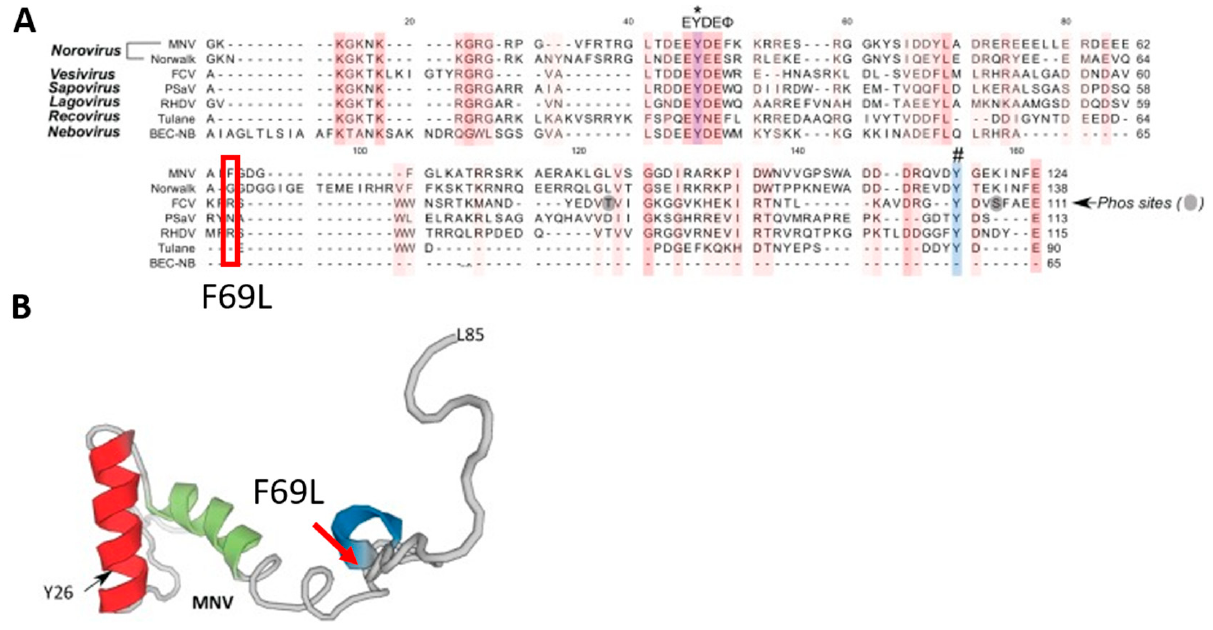
Figure 5. The F69L mutation in the VPg protein detected in compound 6 res MNV variants. One VPg (F69L) mutation detected in the genome of compound 6 res MNV variants. ( A ) Amino acid alignment of VPg sequences among representatives of calicivirus genera: MNV (DQ285629), Norwalk (AF093797), FCV (M86379), PSaV (AF182760), RHDV (Z49271), Tulane (EU391643) and BEC-NB (AY082891). Alignment of the first 20 nucleotides of the genomic. An asterisk (*) indicates the conserved tyrosine (Y) residue essential for calicivirus replication. A hash (#) indicates the Y residue identified necessary for MNV nucleotidylylation using an in vitro biochemical approach. ( B ) The solution structure of the MNV VPg protein (PDB: 2MG4). The MNV VPg structure encompasses amino acids G11 to L85. Reprinted from Ref. [5].